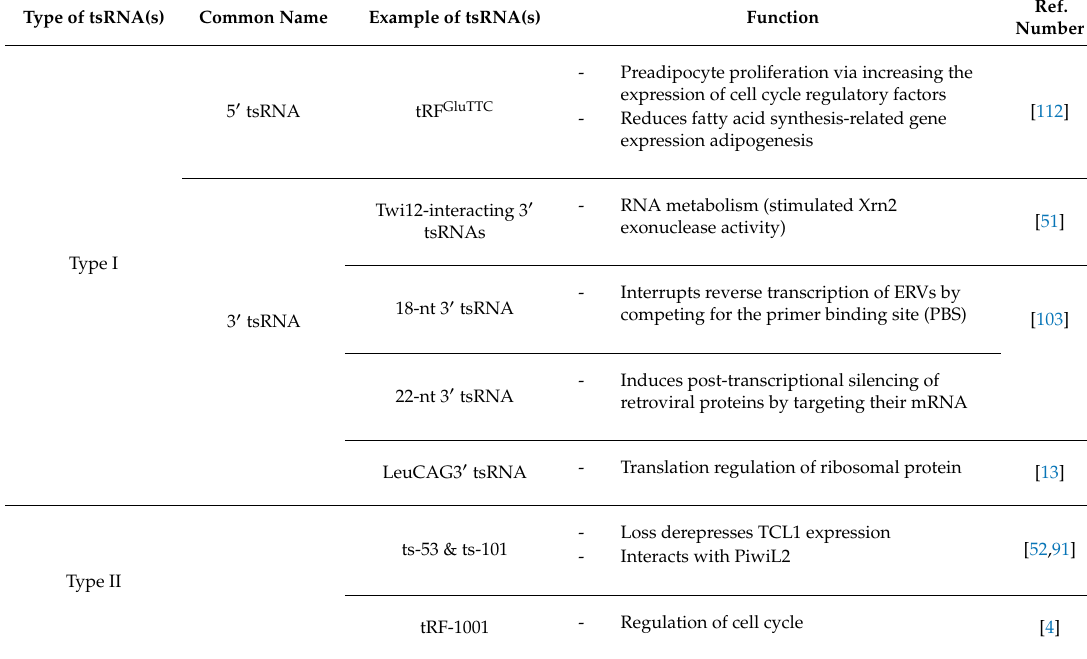
Table 1. Summarized types and function of tsRNA(s) related to epigenetic